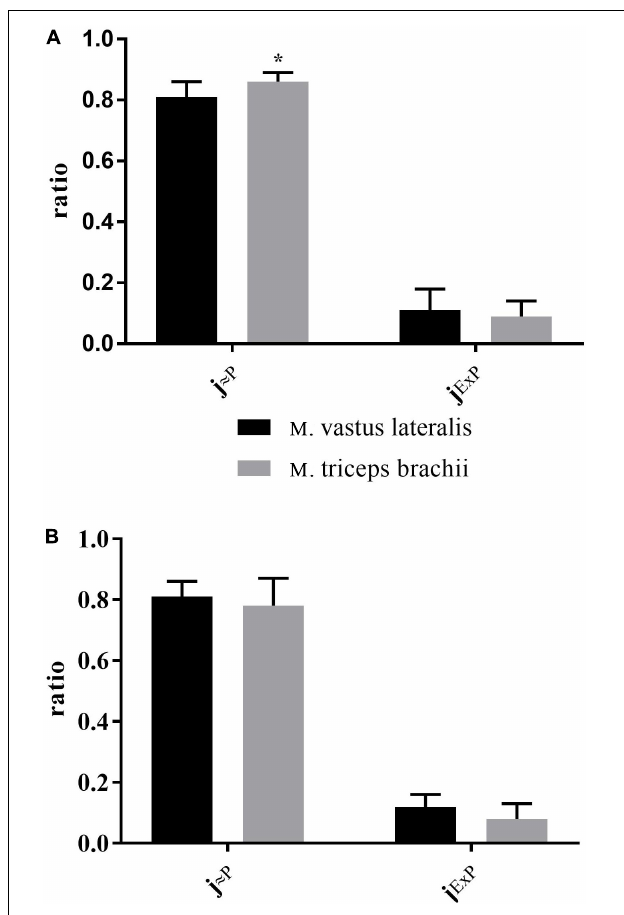
FIGURE 4 | Differences in respiratory control ratios between M. triceps brachii and M. vastus lateralis in XC skiers and CON. (A) elite cross-country skiers (XC skiers) and (B) physically active controls (CON). Mitochondrial quality noted as ratio between 0 and 1 for oxidative phosphorylation capacity efficiency (j ≈ P ) and excess electron transfer system-phosphorylation capacity factor (j ExP ). Data are displayed as means ± SD. ∗ Significant difference between groups ( P <